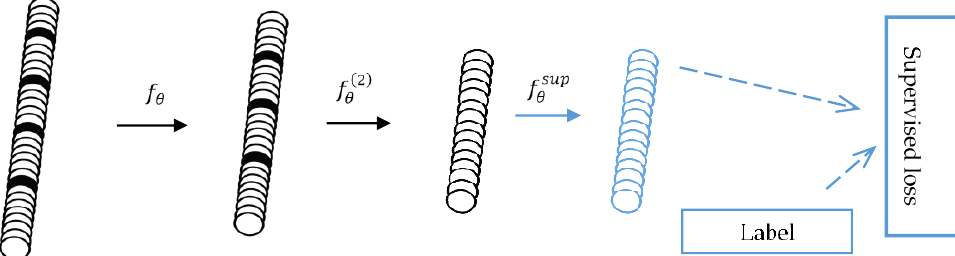
Figure 4. The single SDAE network for classification. After the training of stacking denoising encoders, an output layer is added on the top of the encoding network. By performing the gradient descent on the supervised loss, the classification result of single SDAE can be obtained.